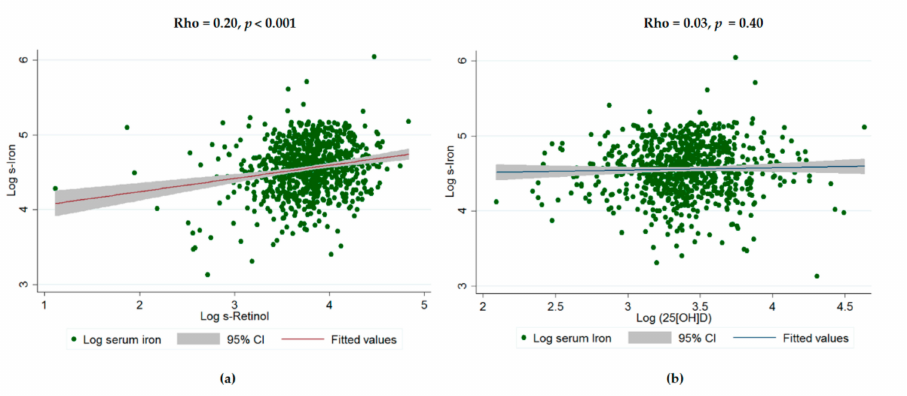
Figure 2. Smoothed correlation of serum retinol and 25(OH)D with serum iron in OA. ( a ) Correlation between log-serum retinol and log-serum iron; and ( b ) correlation between log-serum 25(OH)D and log-serum